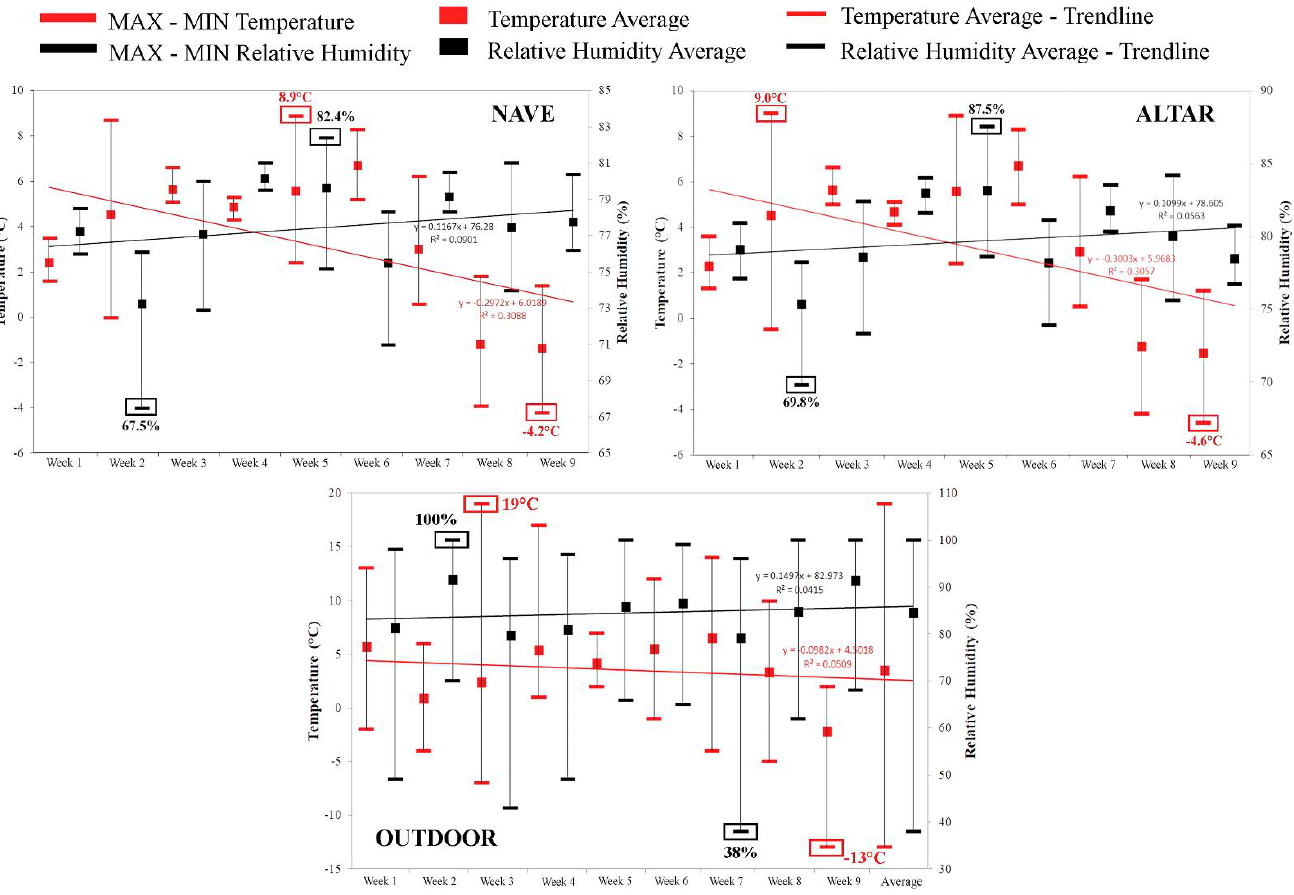
Figure 4. Fluctuations in the minimum, maximum, and average weekly temperature and RH values within the nave and altar of the historic wooden church in Boianu Mare, Romania .